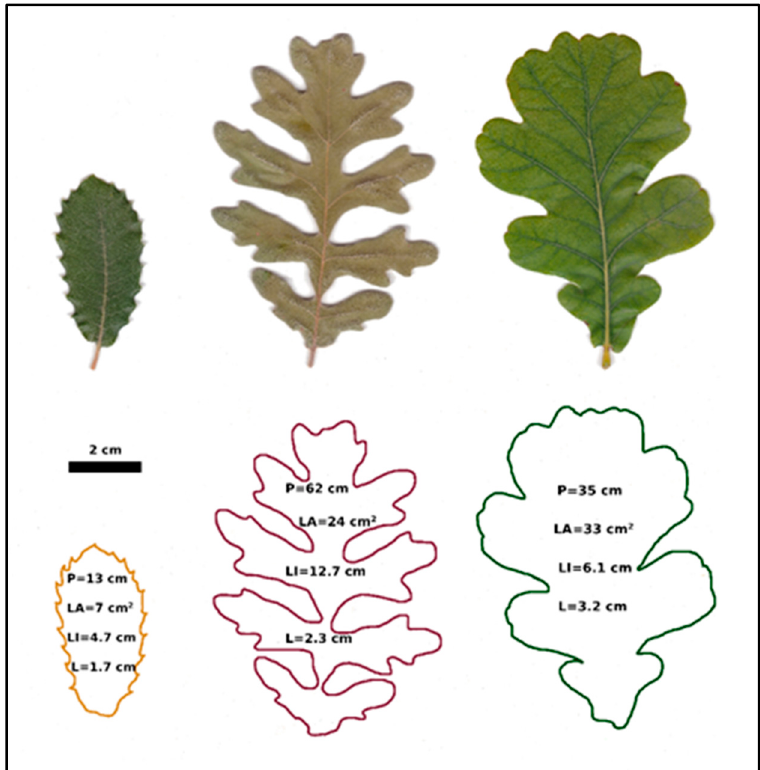
Figure 4. Evolution of leaf size and shape in three white oaks from a Mediterranean to a Temperate paradigm (from left to right, Q. faginea , Q. pyrenaica, and Q. robur ). P, leaf perimeter; LA, leaf area; LI, lobation index (calculated as LI = P/( √ LA); L, effective dimension of the leaf (calculated as described in Parkhurst et al. [123] assuming free-convection conditions, i.e., still air).